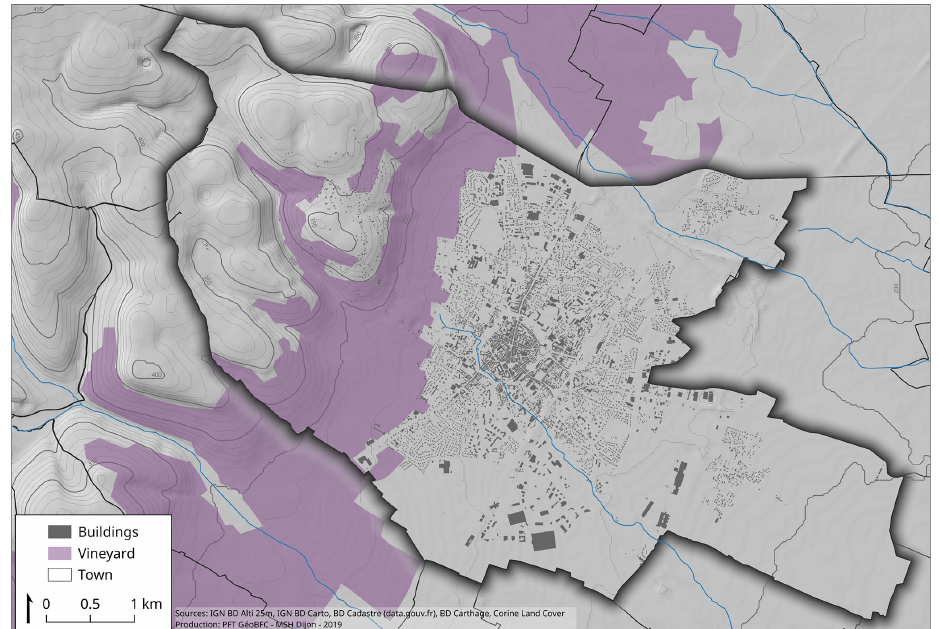
Figure 2. The vineyard of the city of